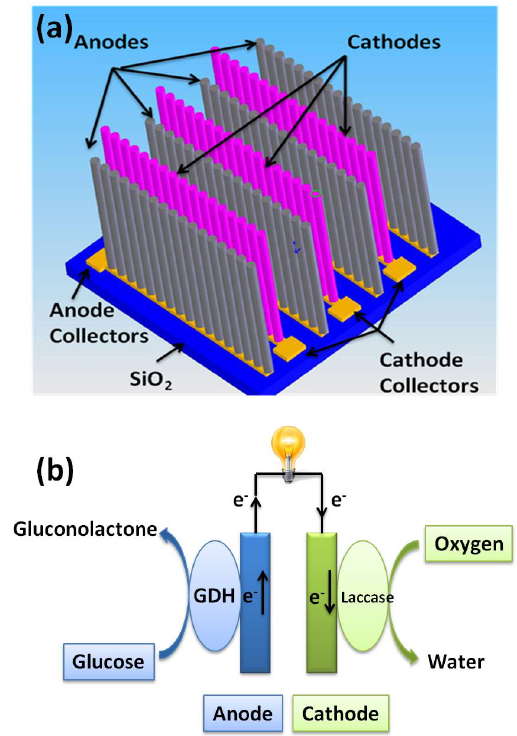
Figure 1. ( a ) A miniaturized EBFC with 3D interdigitated microelectrode arrays; ( b ) schematic depiction of EBFC reaction